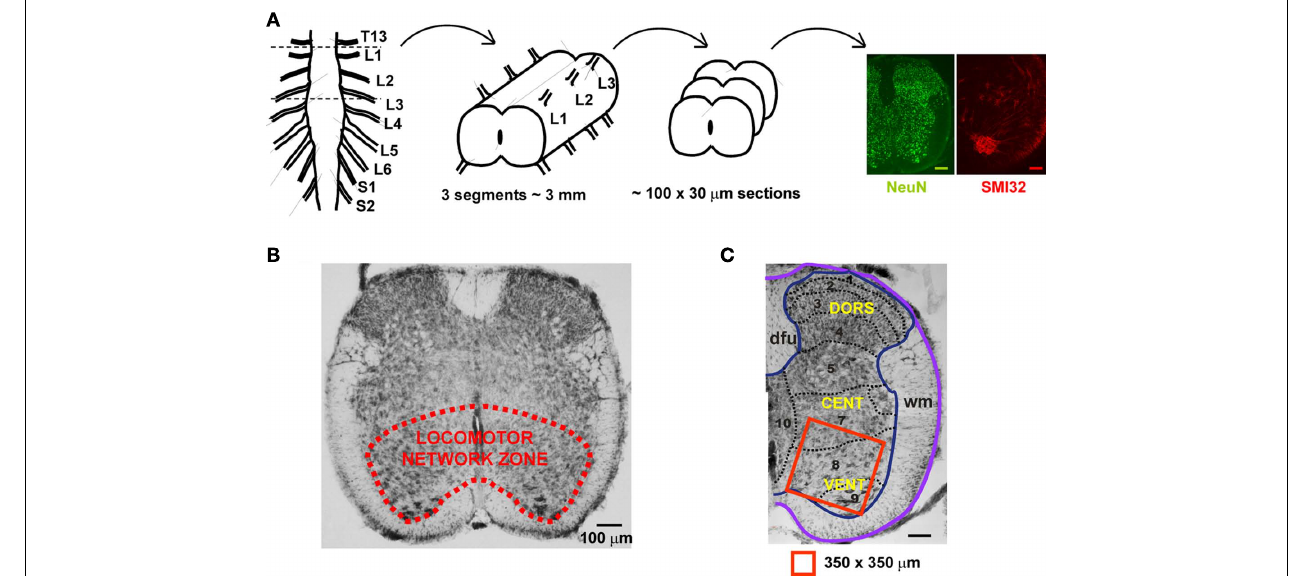
Scale bars = 100 μ m. (B) The locomotor network zone is outlined in the ventro-medial area of a 30 μ m section from the upper lumbar region. (C) Example of hemisected section comprising the location of locomotor networks (laminae 7, 8, and 9 shown in red box of 350 × 350 μ m) used for counting of the number of neurons and motoneurons. DORS, dorsal; CENT, central;VENT, ventral; dfu, dorsal funiculus; wm, white